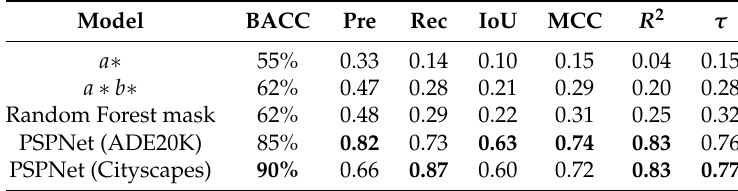
Table 2. Performance comparison of competing approaches to classify vegetation pixels in Mapillary dataset.